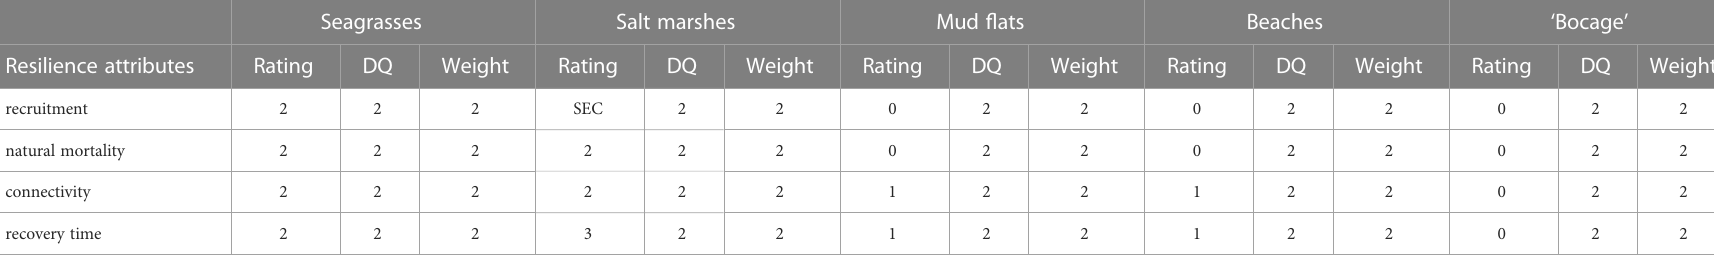
TABLE 4A Rating of consequence criteria (resilience attributes).